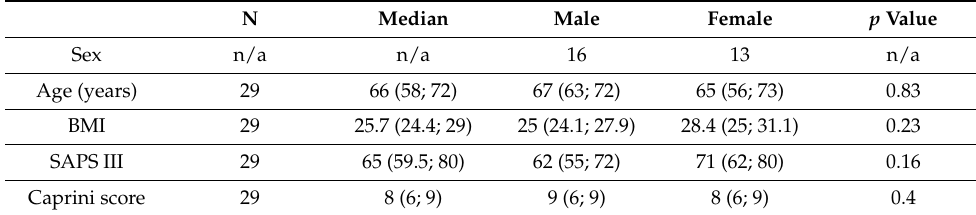
Table 1. Pertinent patient data broken down by sex. N Median Male Female